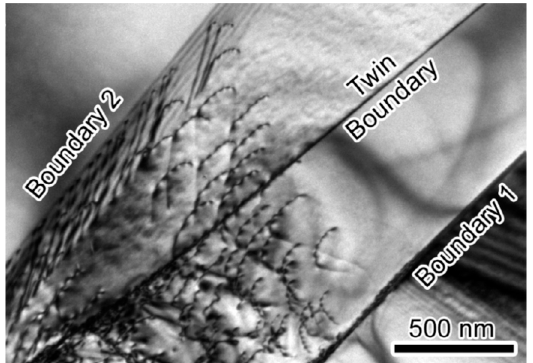
Figure 17. TEM image of direct dislocation transmission without leaving residual dislocations on the coherent twin boundary. (Reprinted from Reference [29], with permission from Elsevier).